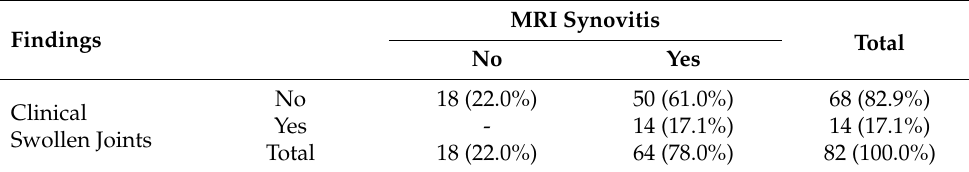
Table 2. Prevalence of synovitis in clinical findings compared to MRI